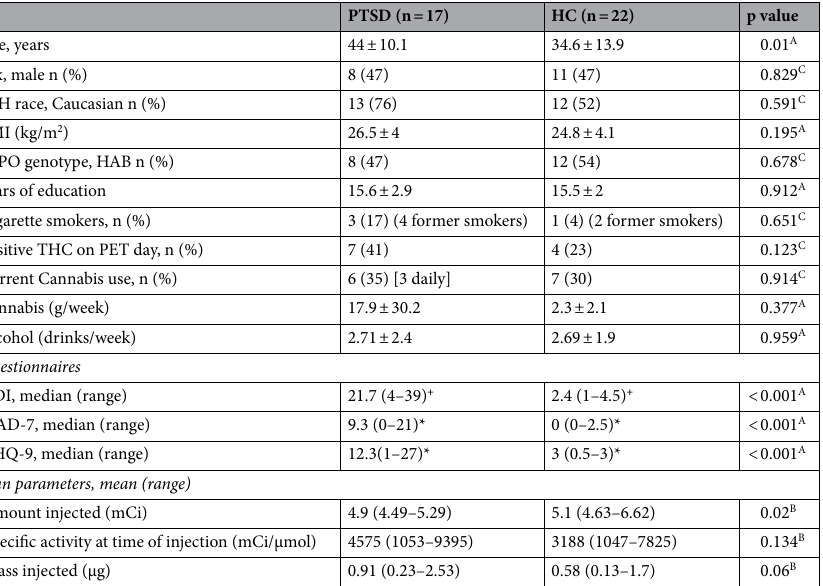
Table 1. Participant demographics: PTSD and HC. Values are mean ± SD unless otherwise indicated. Evaluated by T-Test A , Mann–Whitney U Test B , Chi Square Test C . PTSD: n = 10* & n = 20 + . HC: n = 15* & n = 14 + . BMI Body mass index, HAB high affinity binder, BDI Beck Depression Inventory, GAD-7 General Anxiety Disorder-7, g grams, NIH National Institute of Health, PHQ-9 Patient Health Questionnaire-9, THC tetrahydrocannabinol, TSPO translocator